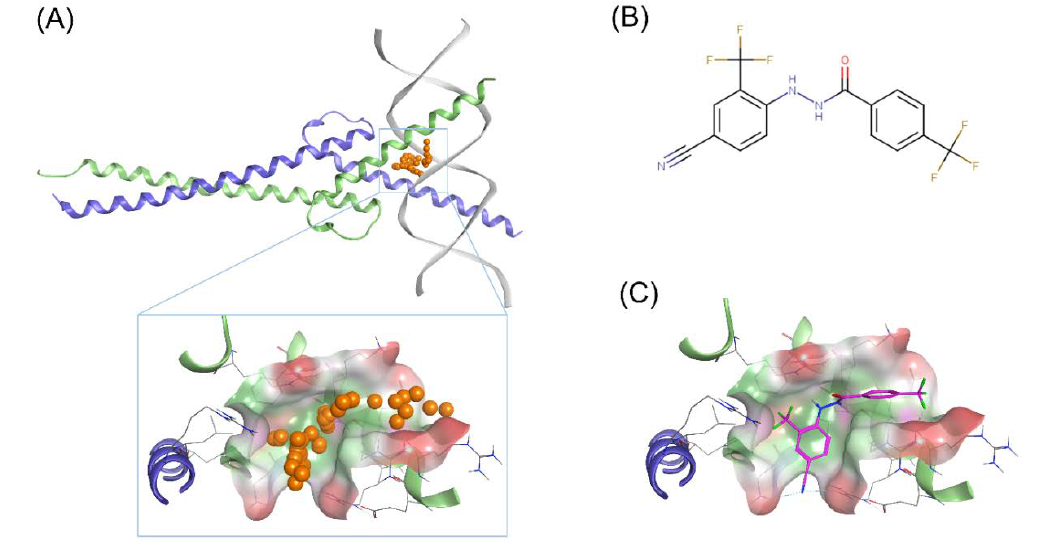
Figure 1. Proposed binding mode of 70551 into the N-Myc-Max DNA-binding domain (DBD) pocket. ( A ) Homology model of N-Myc-Max with the predicted binding site from MOE site finder (top) Max: green ribbons, N-Myc: blue ribbons, and DNA duplex: white. The dummy atoms in orange are used to represent the site, and potential occupancy for inhibition (bottom). Compounds occupying the same positions would clash with the DNA duplex. Hydrophobic surface: green, polar surface: pink, and exposed surface: red. The site is the same one as proposed in our previous publication with 70063. ( B ) 2D representation of the N-Myc specific lead, 70551. ( C ) 70551 in the proposed binding site of N-Myc-Max DBD. Ligand interaction network reveals one strong H-bond with Arg215 from 70551’s nitrogen group in its hydrazide